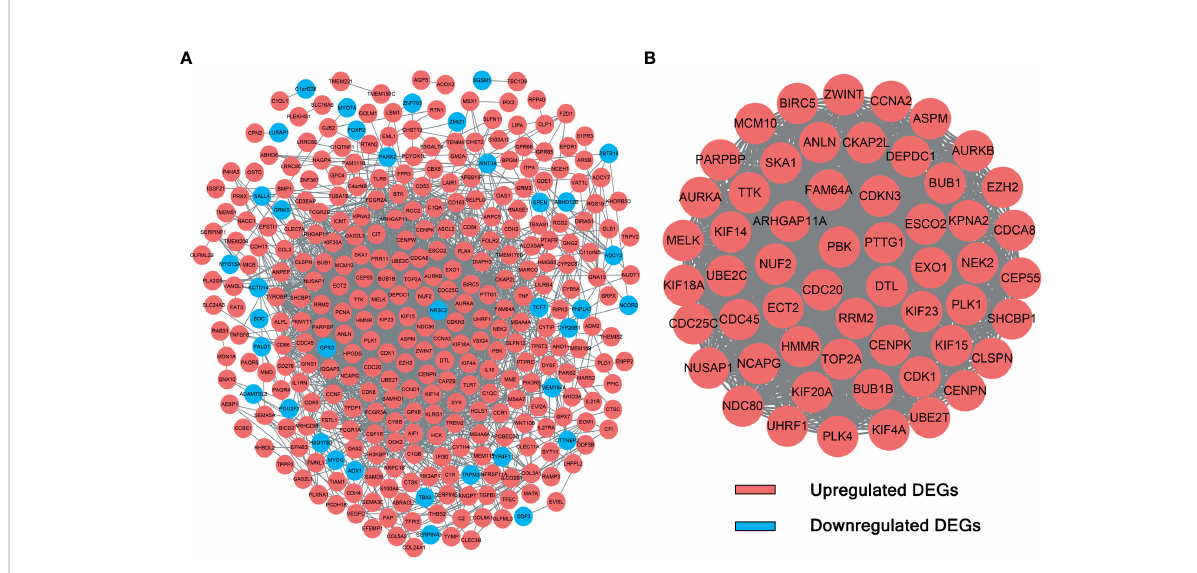
FIGURE 2 PPI network and module analysis. (A) The 339 DEGs in the PPI network. (B) Hub DEGs identi fi ed by module analysis using MCODE.